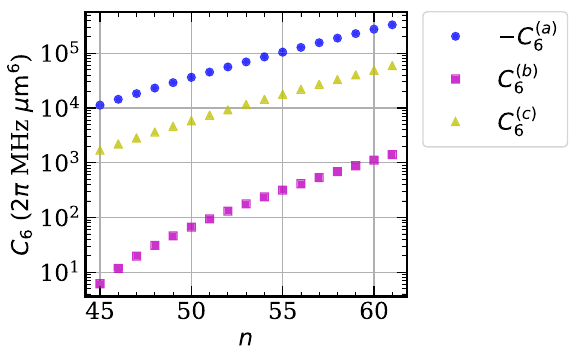
FIG. 9. The C (ν) coefficients as a function of the principal 6 quantum number for the n 2 P 1 / 2 manifold.